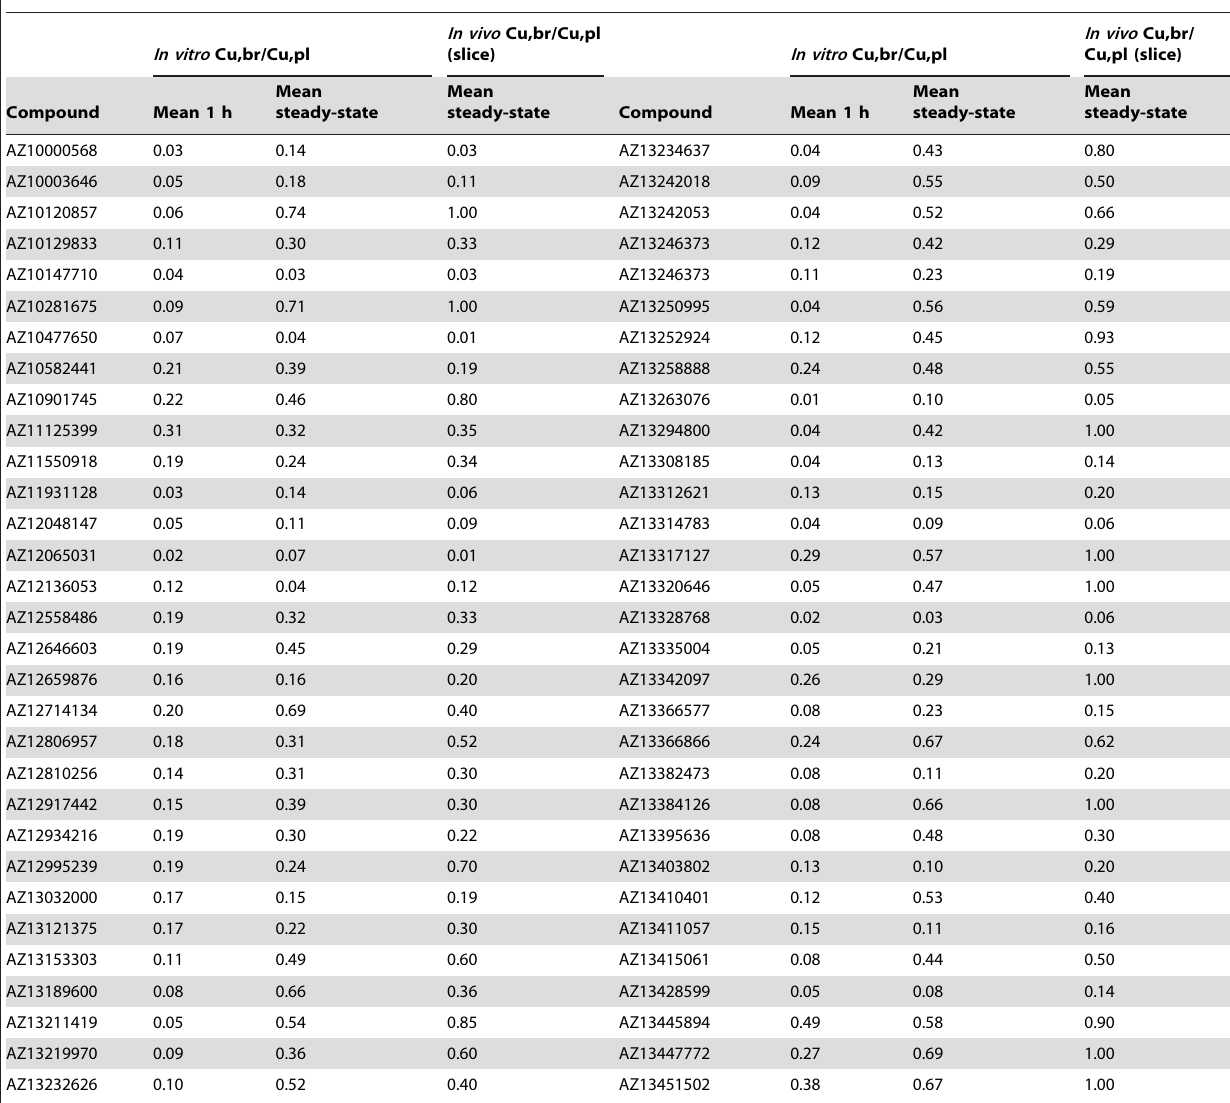
Table 3. In vivo and in vitro Cu,br/Cu,pl of 62 proprietary compounds.